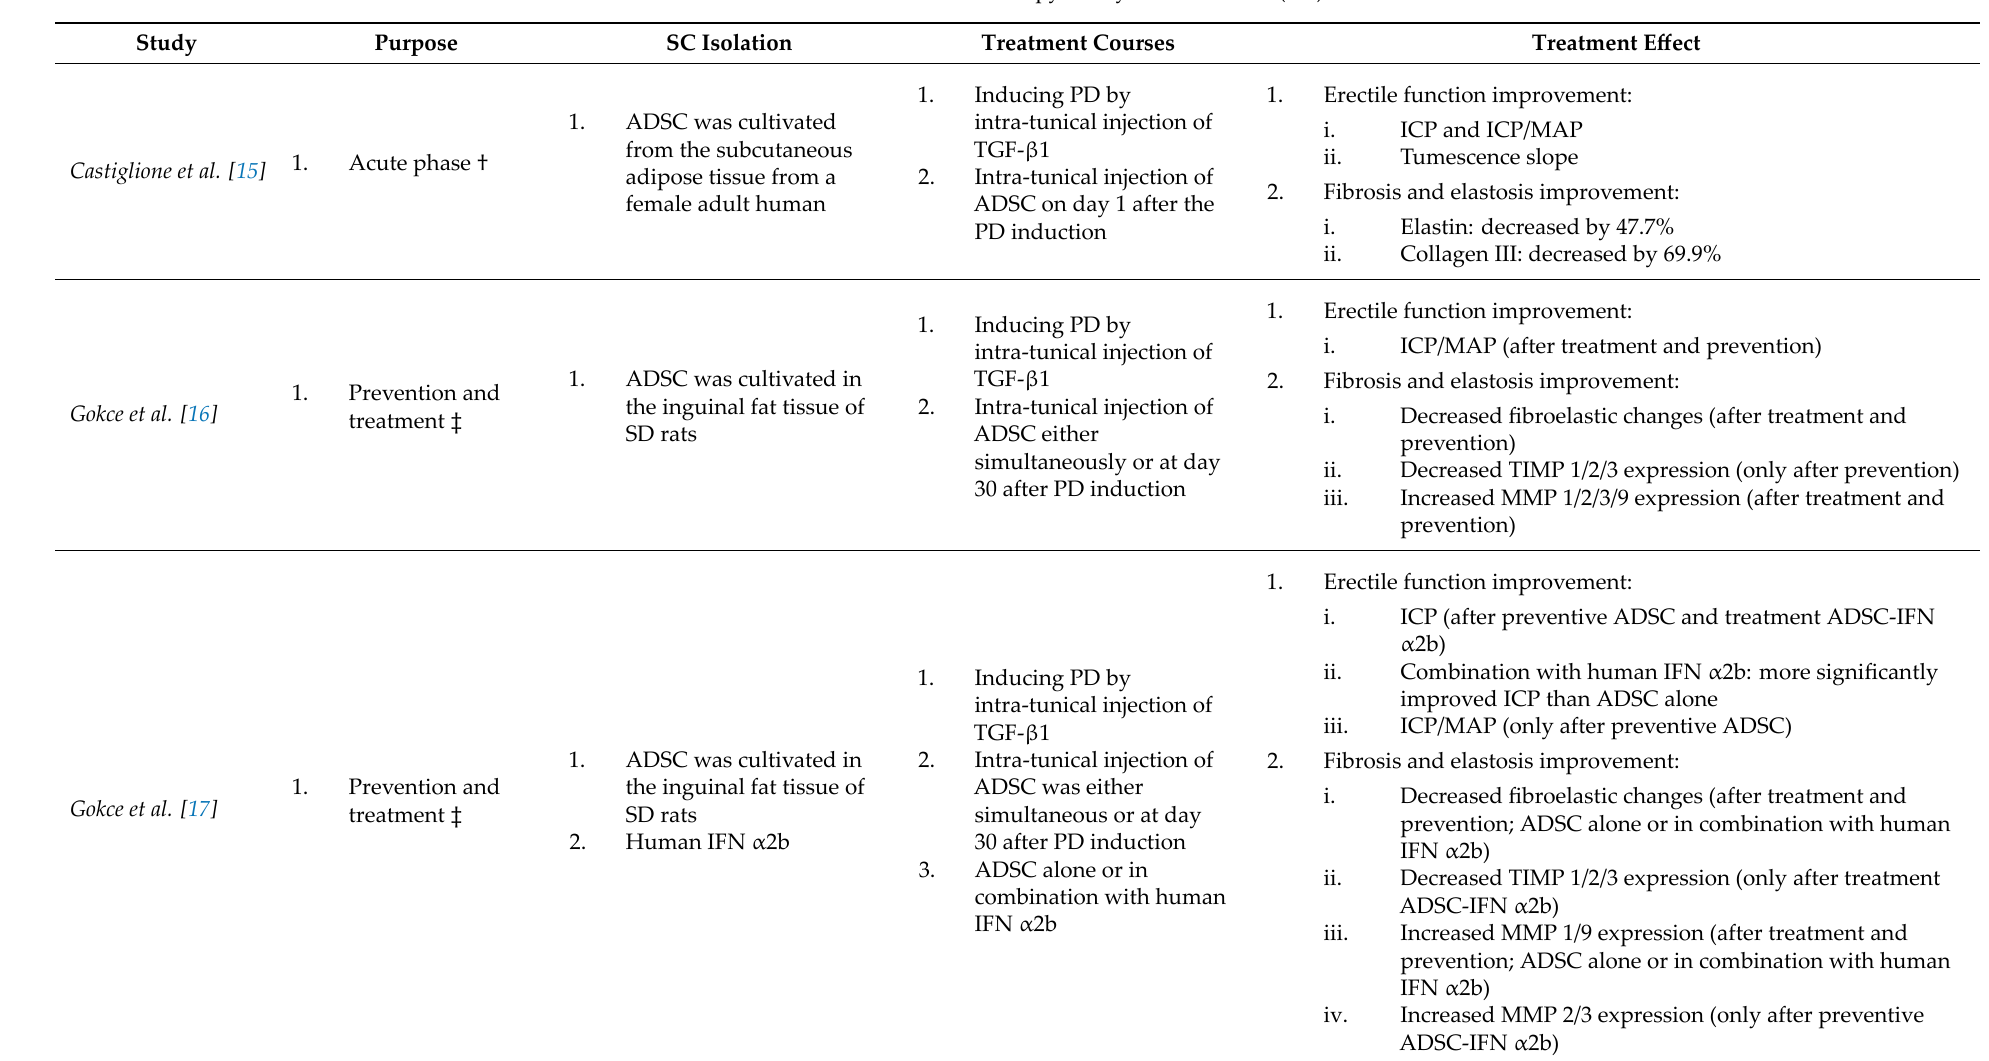
Table 2. The current animal and in‑vitro studies of stem cells therapy in Peyronie’s disease